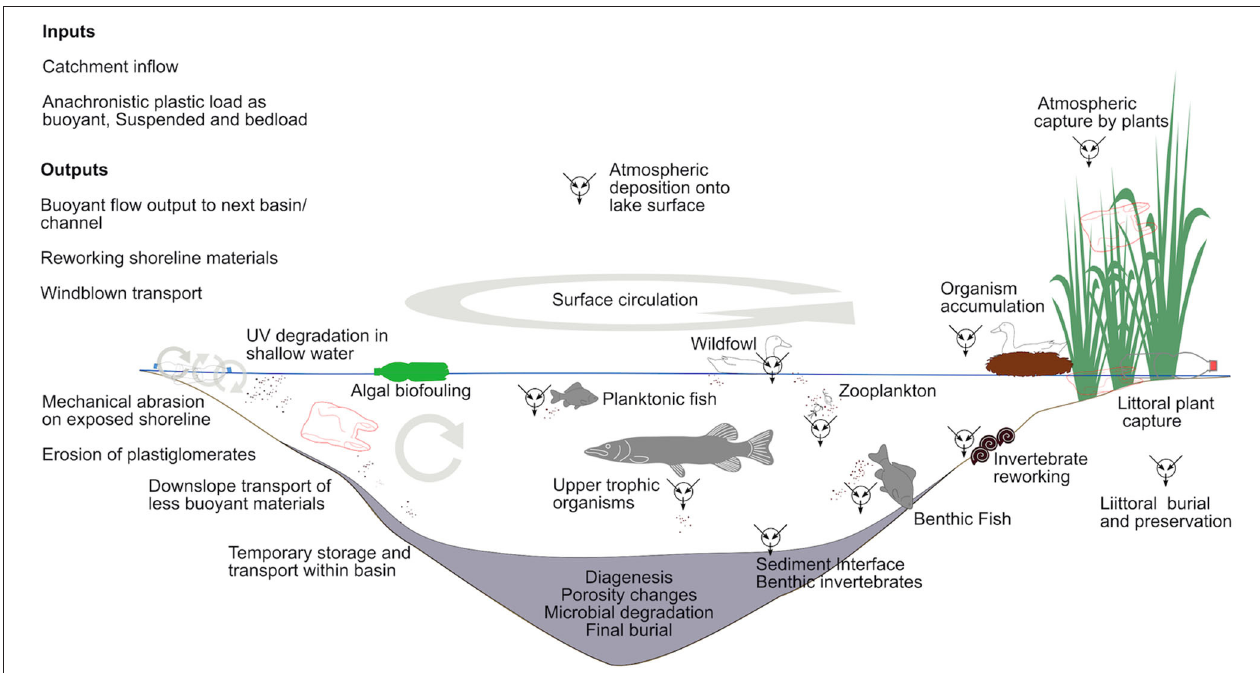
FIGURE 2 | Indirect transport of microplastics to a simple aquatic basin and sediment sequence. Plastic waste is transported to and broken down by interacting physical, chemical, and biological